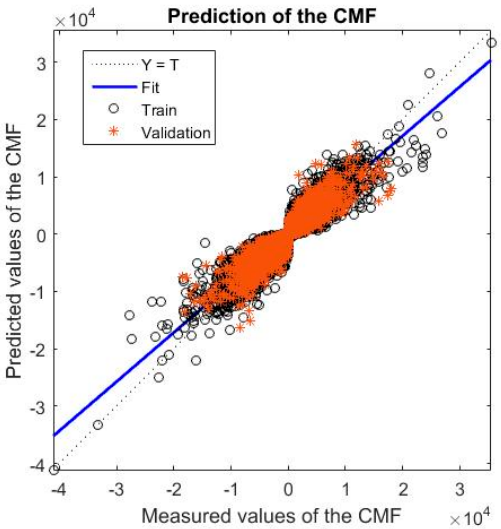
Figure 8. Regression plot for the prediction of the CMF over the segments by the NN on the training set and validation set of Dataset 2.